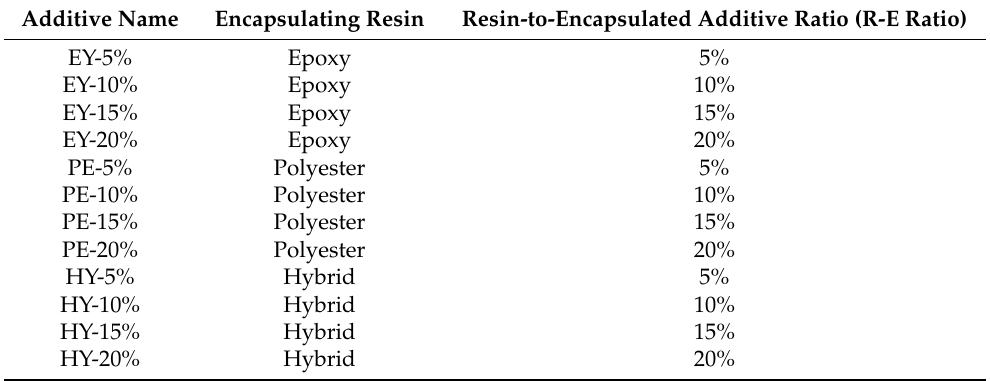
Table 2. List of additive